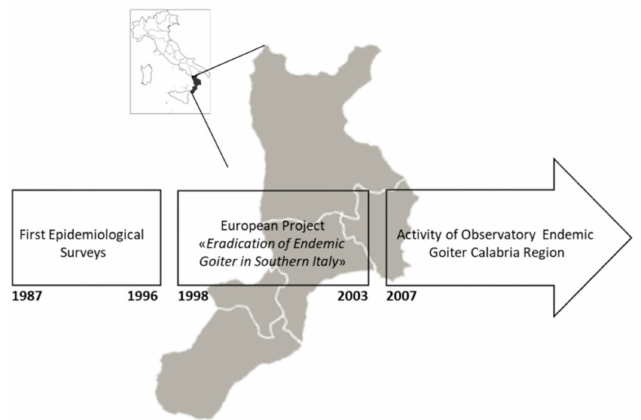
Figure 1. Schematic representation of the key steps of epidemiological surveys conducted from the late 1980s to the present for assessing and monitoring iodine status in the Calabria